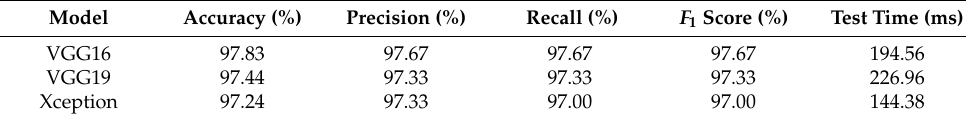
Table 4. Performance of CNN models.